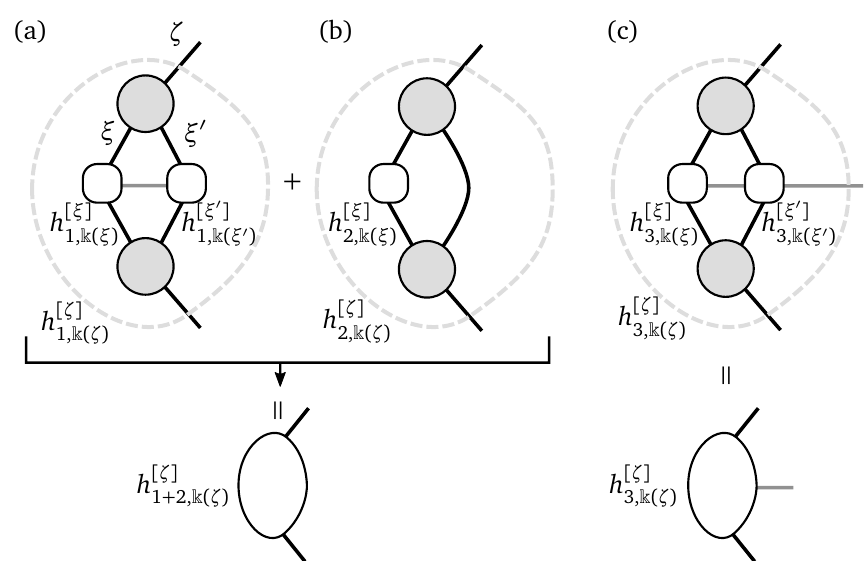
Figure 38: Example for summation over renormalized Hamiltonians without open TPO links: the resulting TPO tensors on link ζ (dashed) in (a) and (b) have no open TPO links, they can therefore be summed over, and saved in a single tensor. In (c), this is not the